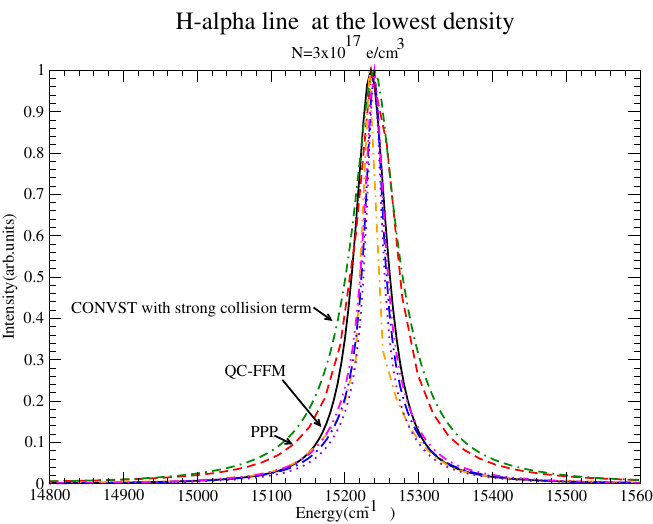
Figure 10. H α at the lowest density. Shown are QC-FFM (solid), PPP (dashed), DWE (dash-dotted), CONVST without strong collisions (dotted), CONVST with strong collisions (dot-double dashed), CONVPST without strong collisions (long dash-dotted) and CONVPST with strong collisions (dash-double dotted). Note the good agreement betwen DWE, CONVPST and QC-FFM, while according to most codes, the strong collision term in CONVST appears to significantly overestimate the width, while ignoring it significantly underestimates it. PPP also appears to overestimate the width, as expected due to the GBK operator without frequency dependence.